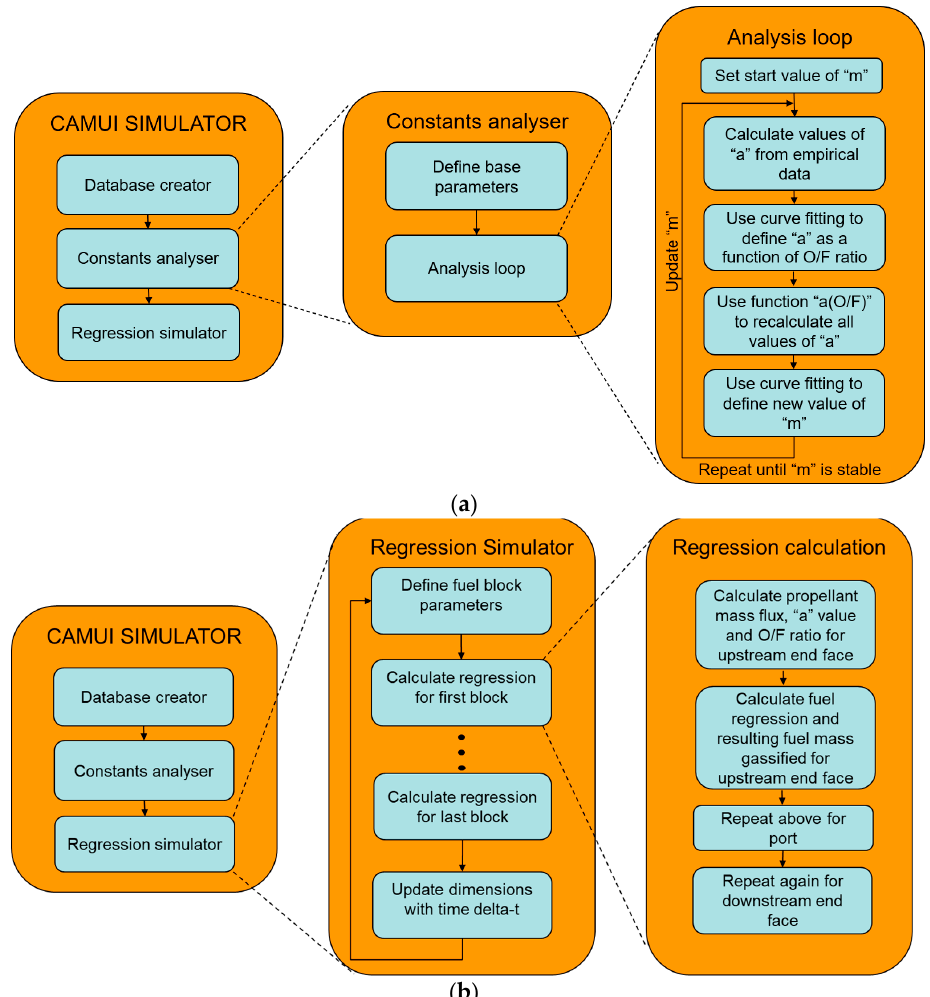
Figure 2. CAMUI simulator concept. ( a ) Constants analyzer. ( b ) Regression simulator.